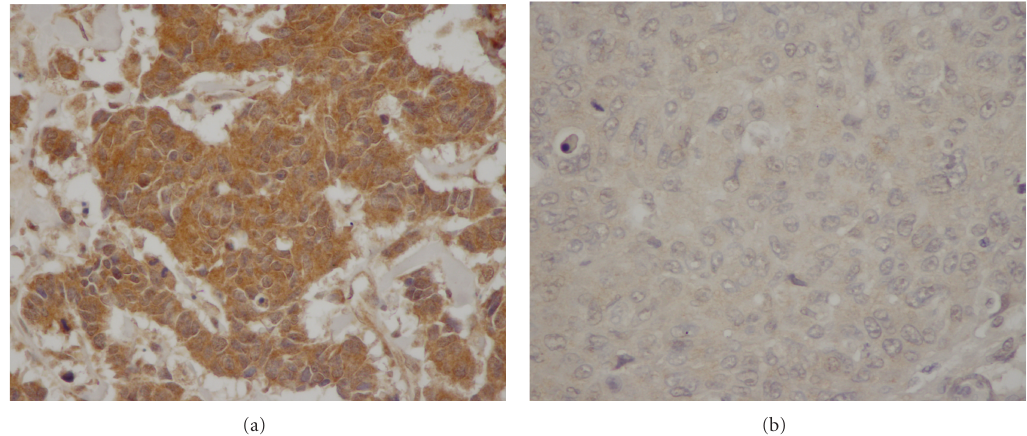
Figure 3: (a) High cytoplasmic overexpression of TIMP-1 (3 + ). (b) No cytoplasmic expression TIMP-1